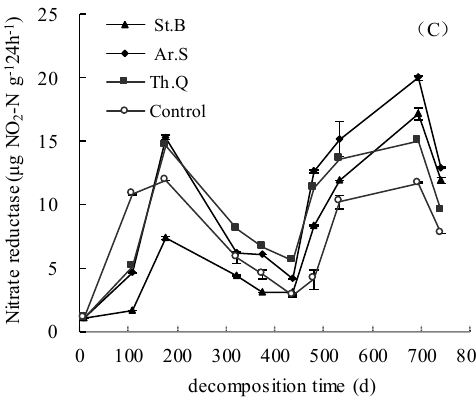
Figure 3. The change characteristics of the activities of soil invertase ( A ), soil urease ( B ) and soil nitrate reductase ( C ).